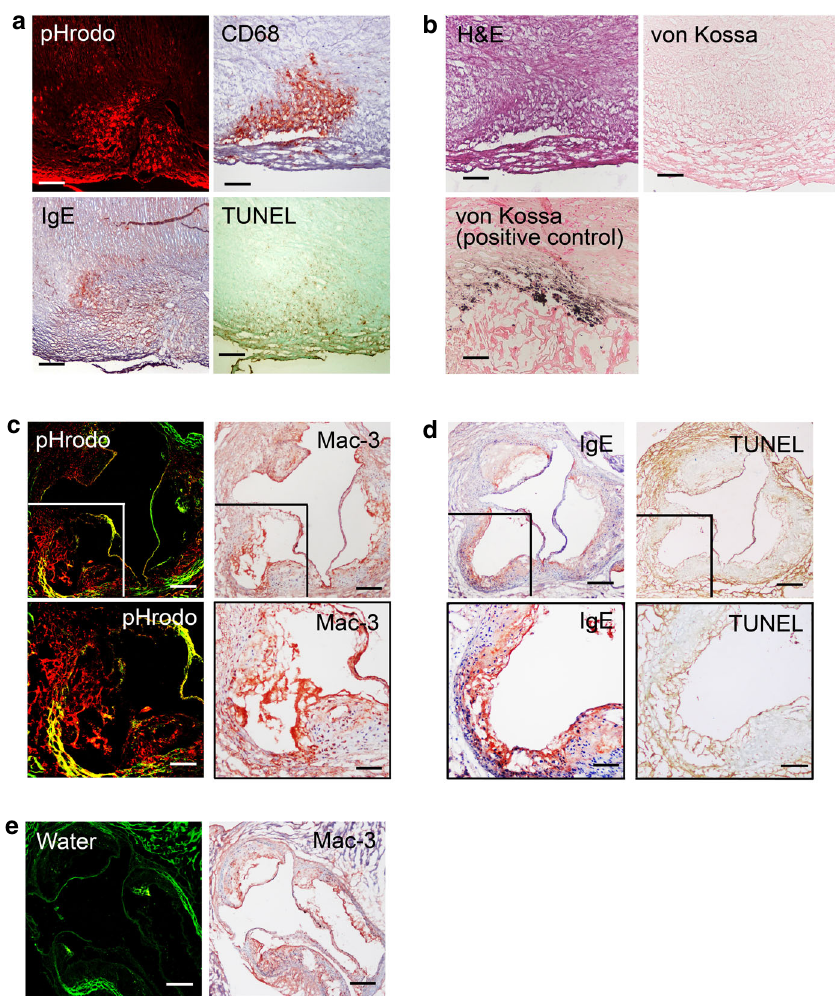
Fig. 1 Acidic human and murine atherosclerotic lesions are rich in macrophages, IgE expression, and cell apoptosis. a pHrodo-positive acidic area, CD68- positive macrophages, IgE, and TUNEL-positive cells are colocalized in parallel sections from human atherosclerotic lesions (data are representative from fi ve donors). b Parallel section hematoxylin and eosin staining and von Kossa staining for tissue morphology and calci fi cation. A human atherosclerotic lesion section with calci fi cation is used as a von Kossa staining positive control. c In parallel atherosclerotic lesion sections from Apoe – / – mice, the pHrodo- positive acidic area (red) are rich in Mac-3-positive macrophages. d IgE expression and TUNEL-positive cells from the same area of panel c . e pHrodo is replaced with water as negative control in atherosclerotic lesion from Apoe – / – mice. Data are representative from seven mice. Bars: 500 µ m,